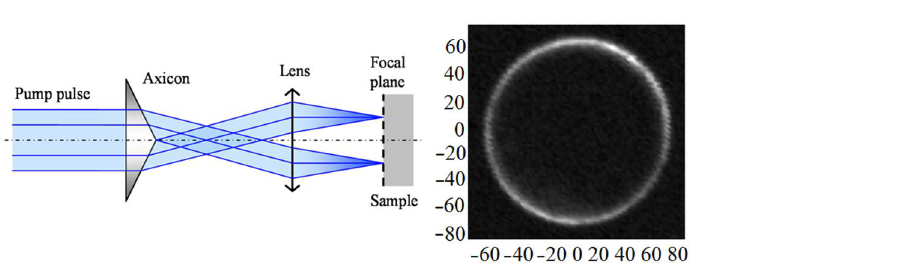
Figure 2. Left: scheme of an axicon application to form a ring excitation. Right: intensity distribution measured on the sample surface.